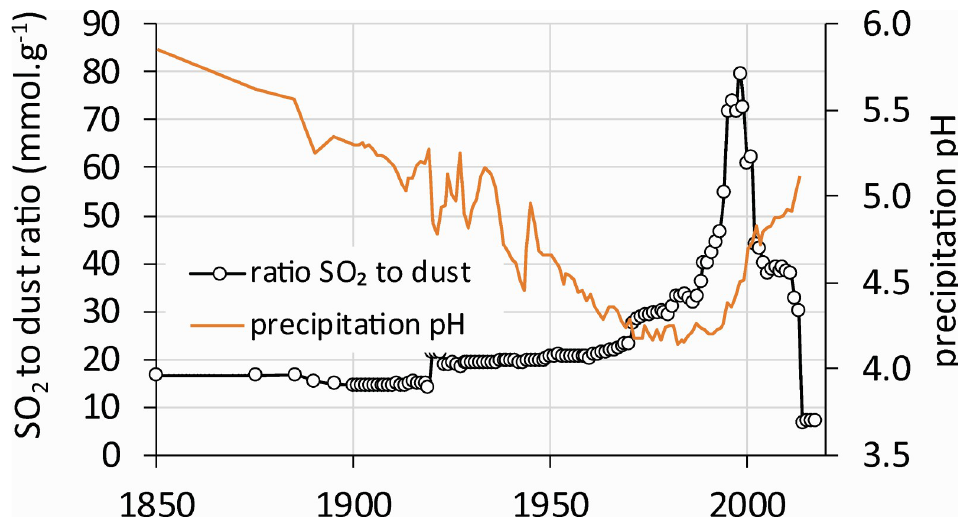
Fig 4. Modelled and measured annual precipitation pH and SO 2 /dust ratio (1850–2017) for the Czech Republic. Modelled values from 1850 to 2013 for pH, 1850 to 2013 for SO 2 /dust